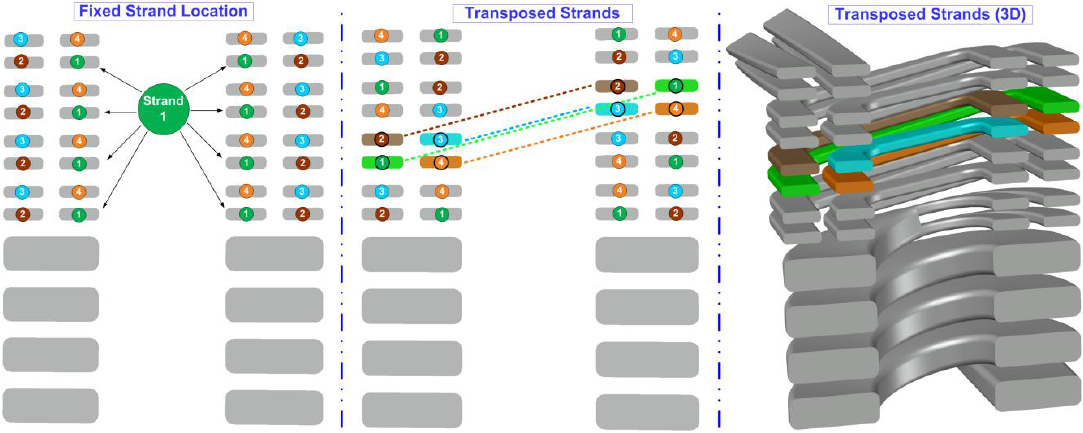
Figure 3. Strands allocation in the fixed strand arrangement and the transposed one.